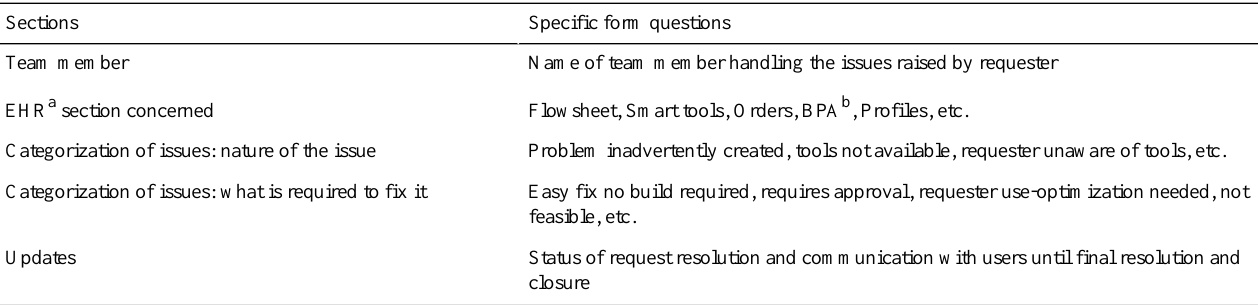
Table 1. The contents of the REDCap form section that will be filled out by a designated Beyond-Getting Rid of Study Stuff (GROSS) team member. Specific form